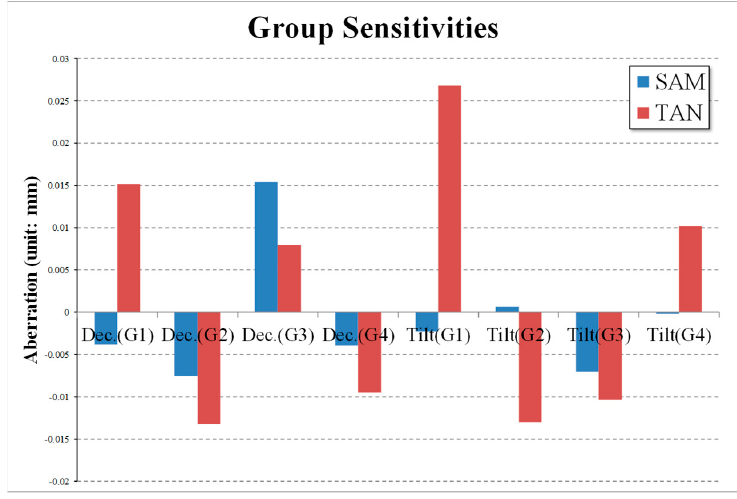
Figure 13. The sensitivities for the decenter and tilt of the lens group.